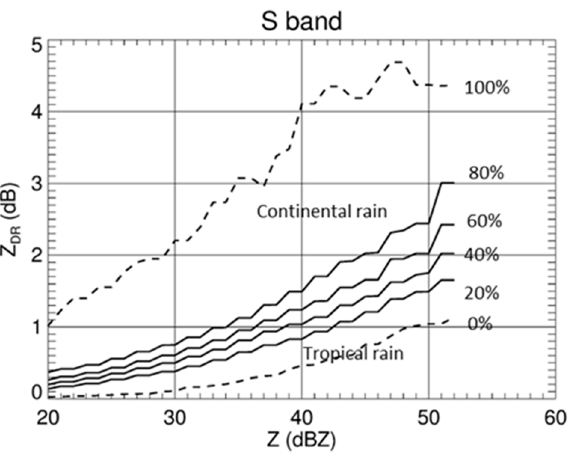
Figure 5. Lines of different percentiles of the Z DR distributions for a given Z obtained from the Oklahoma DSD measurements.